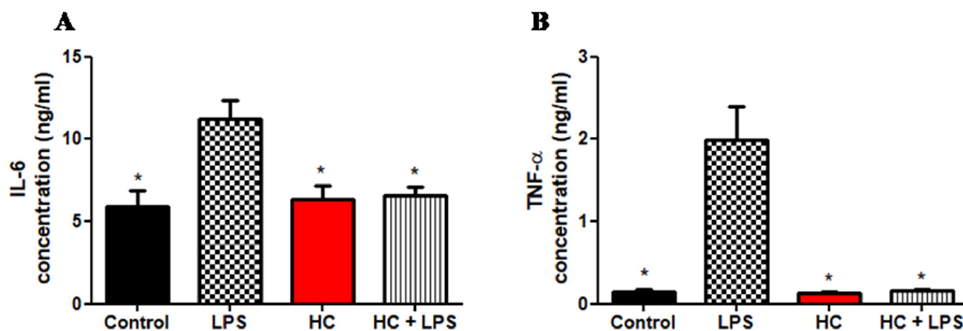
Figure 4. A hydrocolloid patch covered with ZnO nanoparticles accelerates the pro-inflammatory property of the RAW 246.7 cell culture. The concentration gap of pro-inflammation responses between four groups (control, LPS, HC, and HC + LPS) was confirmed by ELISA. ( A ) Interleukin 6, IL-6. ( B ) Tumor necrosis factor-alpha, TNF- α . The asterisks indicates p < 0.05.